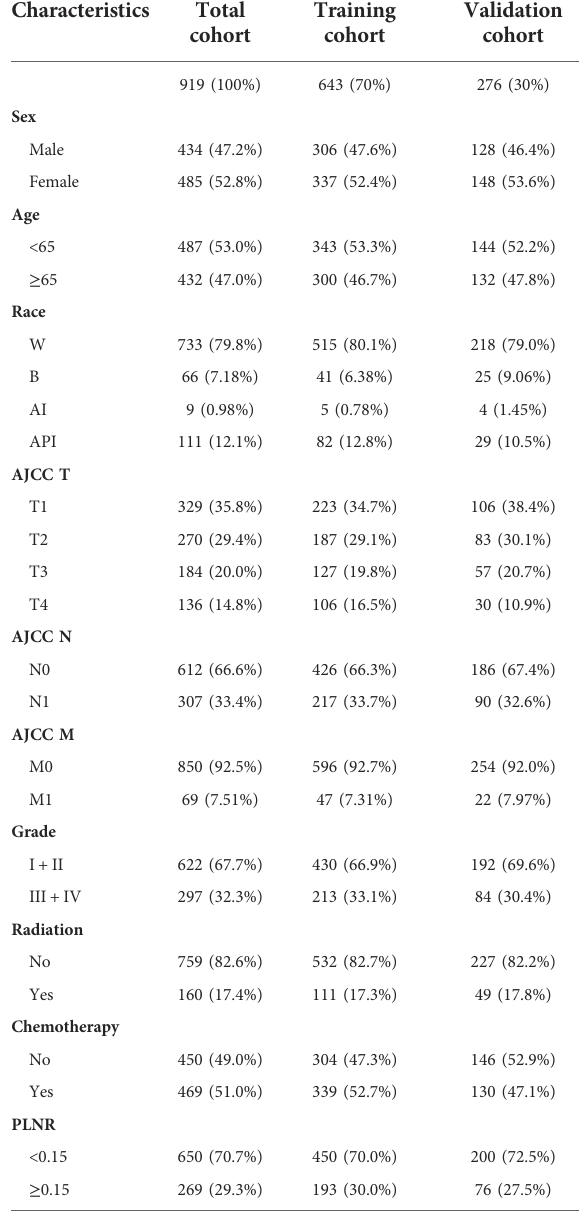
TABLE 1 ICC patient characteristics in the